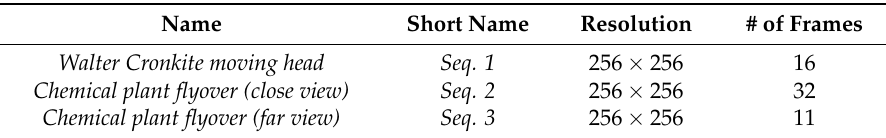
Table 1. Dataset 1